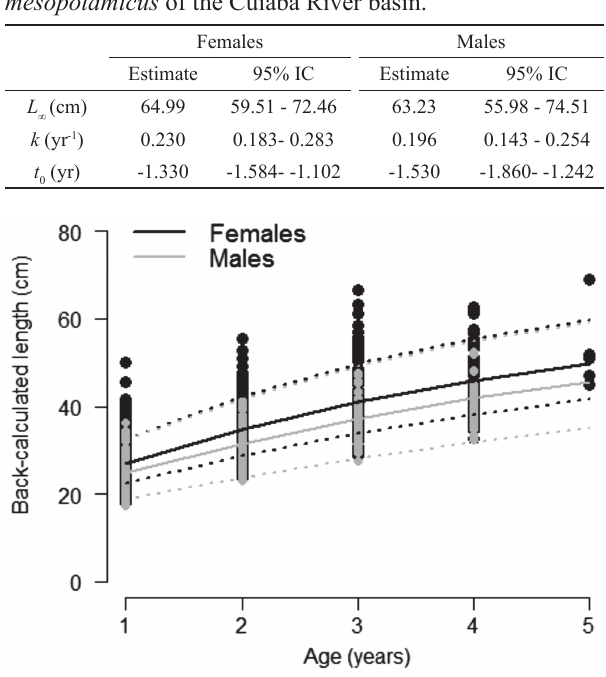
Fig. 5. Growth curves for females (black line) and males (gray line) for Piaractus mesopotamicus sampled in the Cuiabá River basin. The dotted lines are the lower and upper confidence interval limits of the estimated parameters for females (black) and males